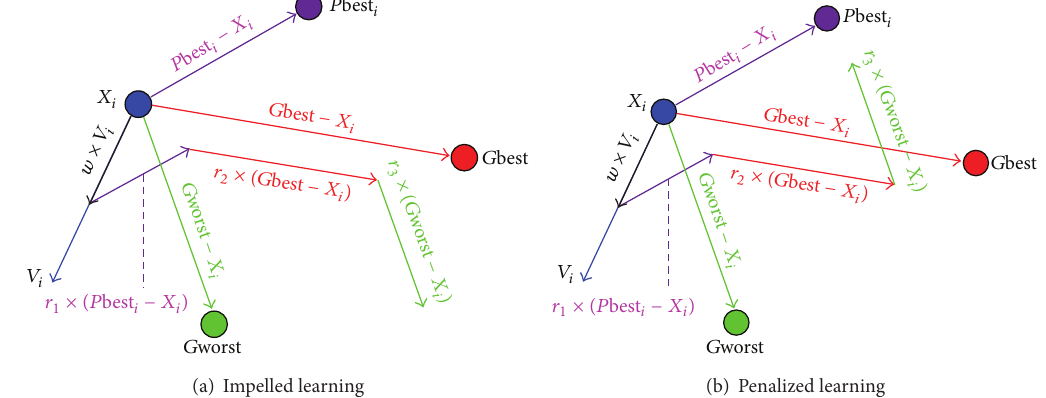
Figure 2: Impelled/penalized term in